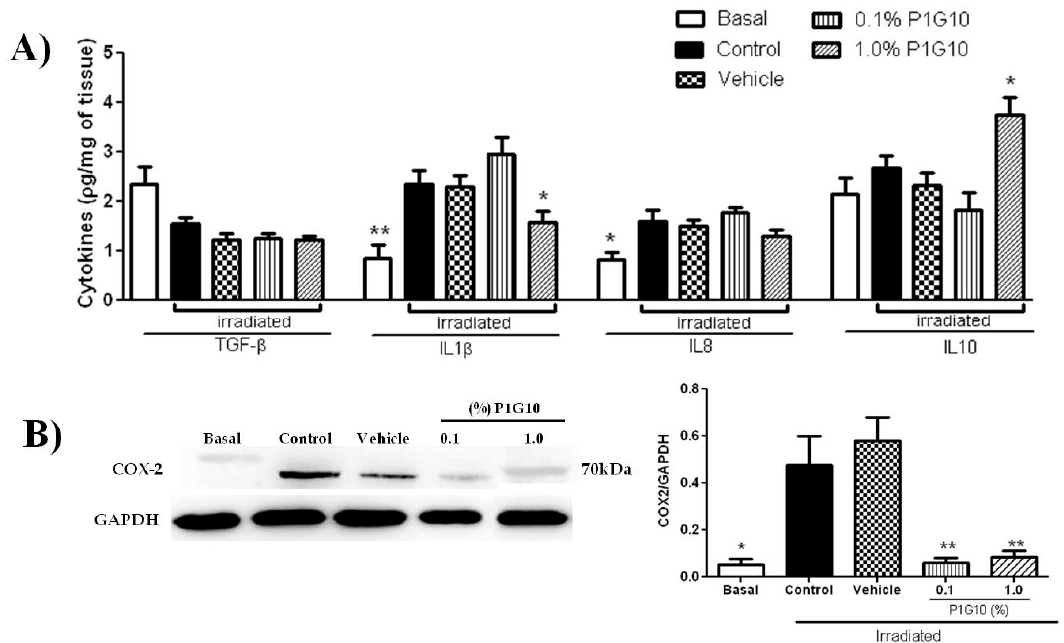
Figure 6. The e ff ect of P1G10 on cytokines and COX2 activity in irradiated mice. Mice were exposed to UVB radiation (2.4 J cm − 1 ) and treated with Natrosol gel, (vehicle) or P1G10. After 24 h, skin samples were dissected and processed for cytokines analysis ( A ) quantitative ELISA of TGF- β , IL1 β , IL8, and IL10. ( B ) COX 2 activity was determined in cell lysates using Western blot analysis. COX 2 level is expressed relative to GAPDH using ImageQuant software. Results represent the mean ± SEM of 6–8 animals per group (* p < 0.05 and ** p < 0.01 di ff erence versus vehicle, ANOVA, Newman–Keuls post-test).